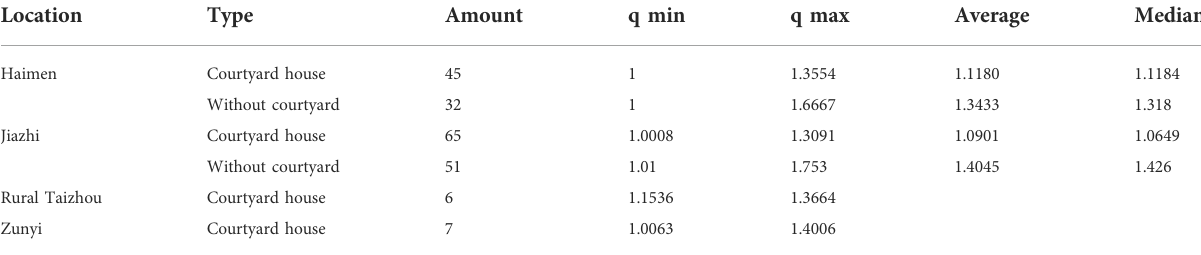
TABLE 4 the q values of 205 cases in South